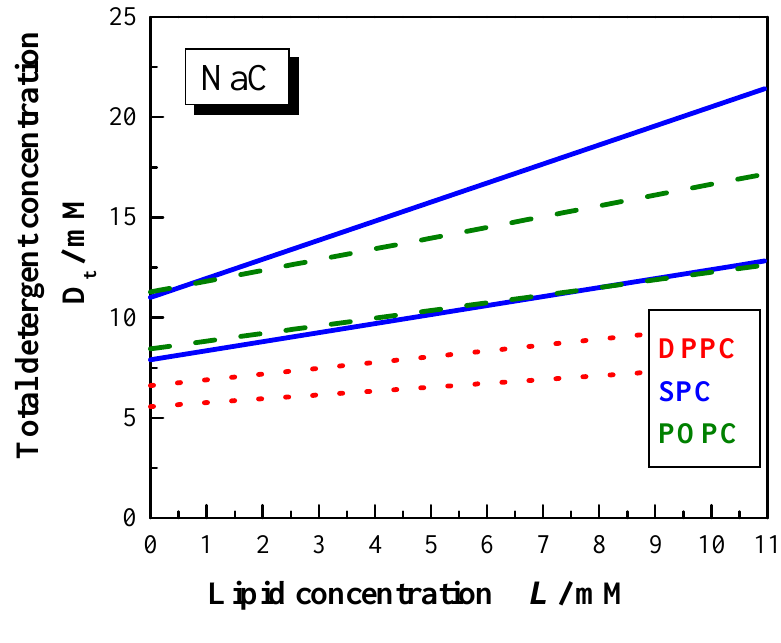
Figure 11. Phase boundaries for the vesicle to micelle transition induced by NaC (100 mM NaCl, pH 7.5) for different lipid systems DPPC (dotted lines), POPC (dashed lines) and SPC (solid lines) at 60 °